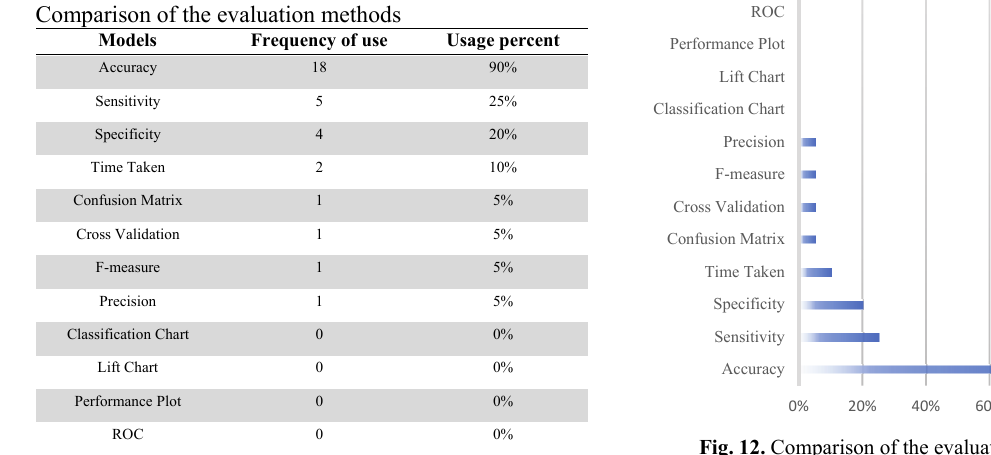
Fig. 12. Comparison of the evaluation methods